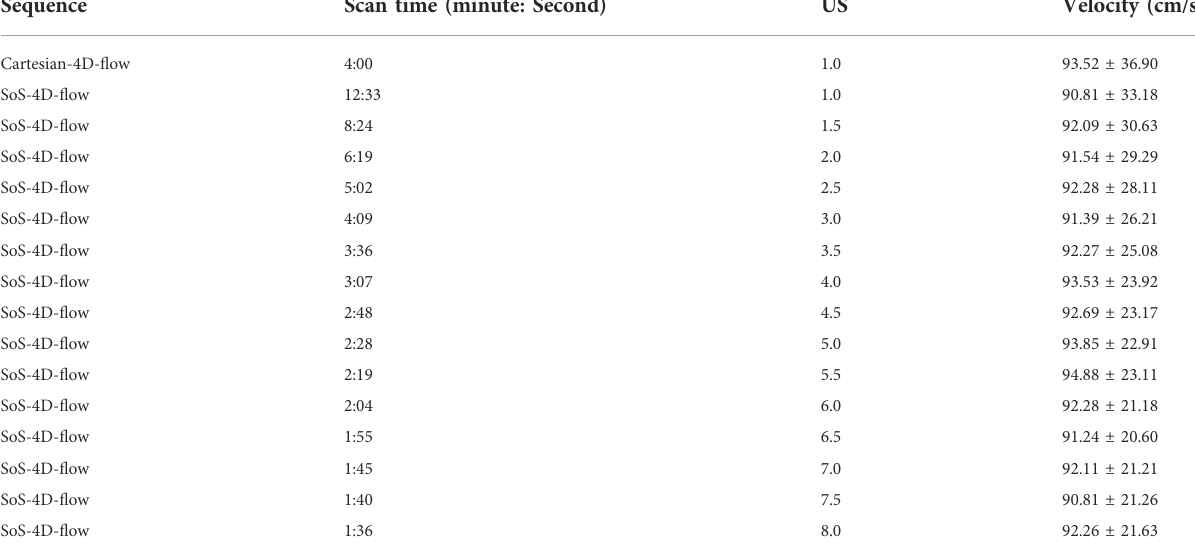
TABLE 2 In-vitro comparison of the velocity values of multiple SoS-4D- fl ow measurements with different undersampling factors to the reference value obtained by the fully-sampled Cartesian-4D- fl ow technique. Sequence Scan time (minute: